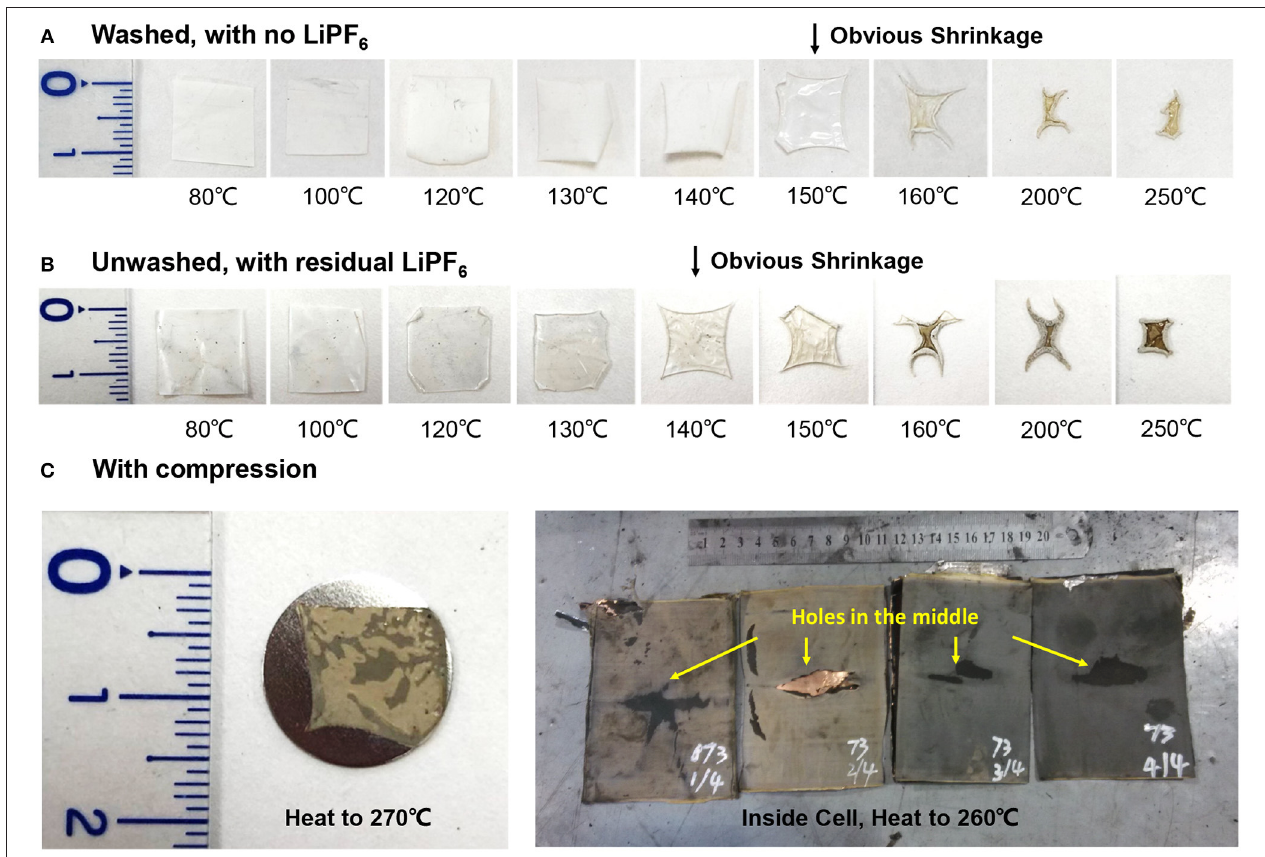
FIGURE 7 | Inferring the collapsing temperature of the PE + ceramic-coated separator, which is from Battery Sample B. (A) Separator heated to different temperatures, with LiPF 6 washed out. (B) Separator heated to different temperatures, with residual LiPF 6 . (C) Separator heated to extreme temperature with compression, with reduced shrinkage.